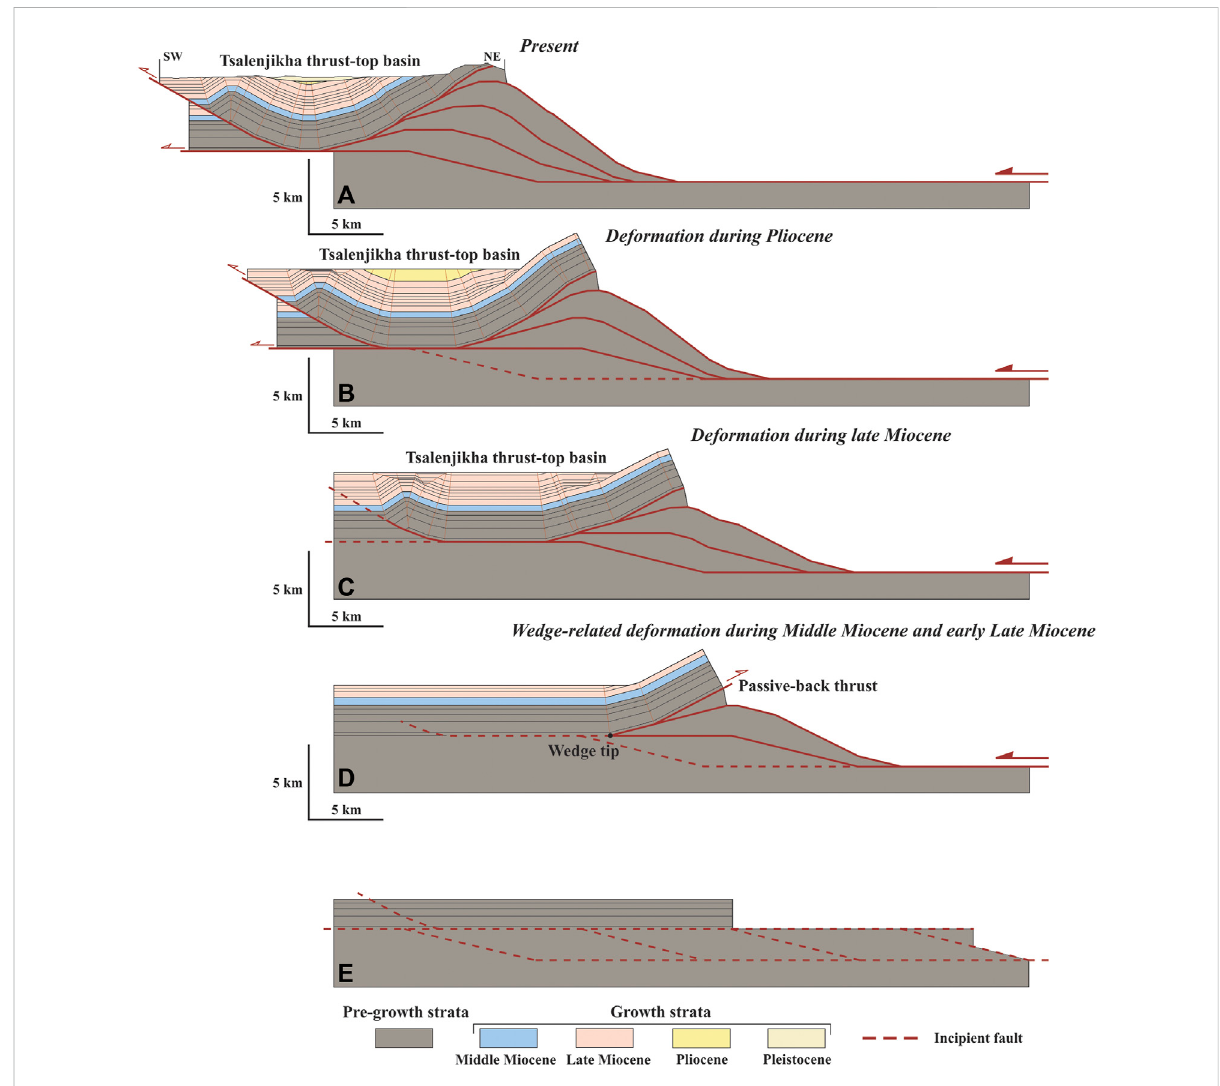
FIGURE 7 Kinematic models of sequential development of Tsalenjikha thrust-top basin. (A) Present-day structure. (B) Deformation during Pliocene. (C) Deformation during the late Miocene. (D) Wedge-related deformation during Middle Miocene and early late Miocene. (E) Restored